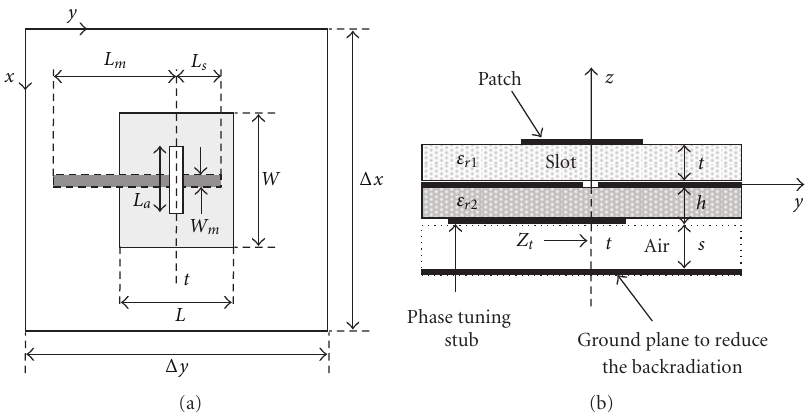
Figure 8: Aperture-coupled reflectarray unit cell—(a) top view and (b) side view.